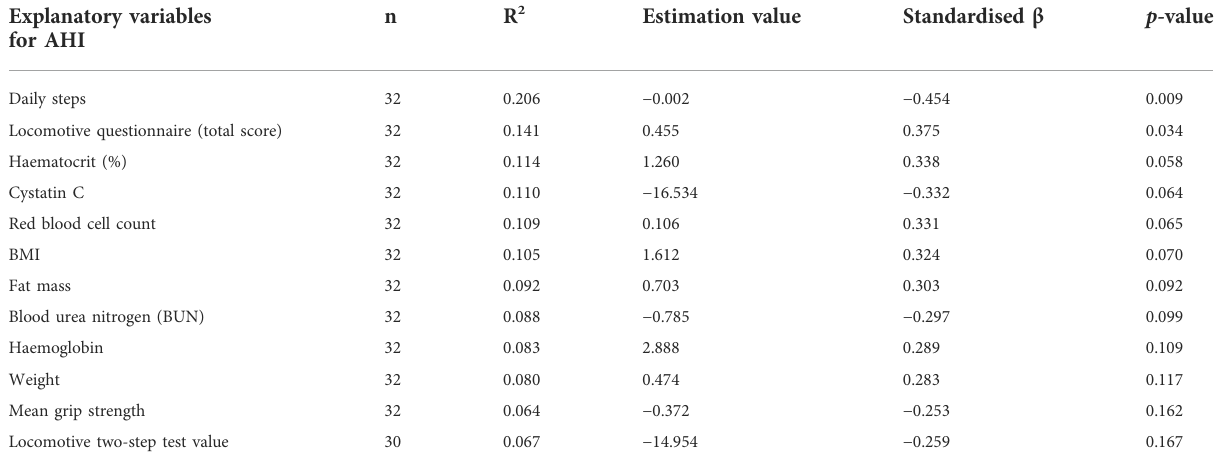
n R 2 Estimation